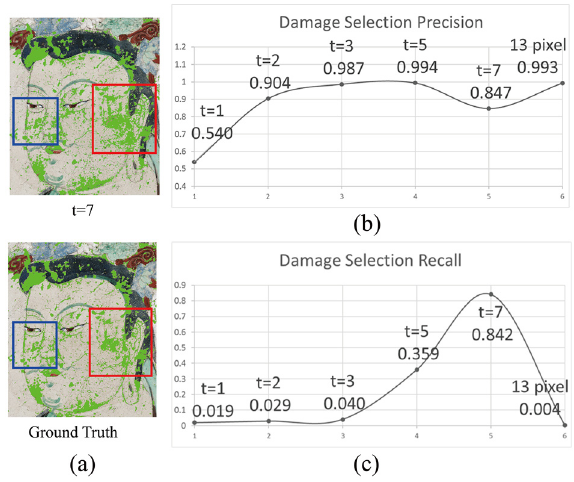
Figure 5. Experimental results of precision and recall. Figure (a) shows partial damage selection result when t = 7 (left) and ground truth (right), defects are shown in green color. For five clicks results, Figure (b) shows the curve of precision and Figure (c) shows the curve of